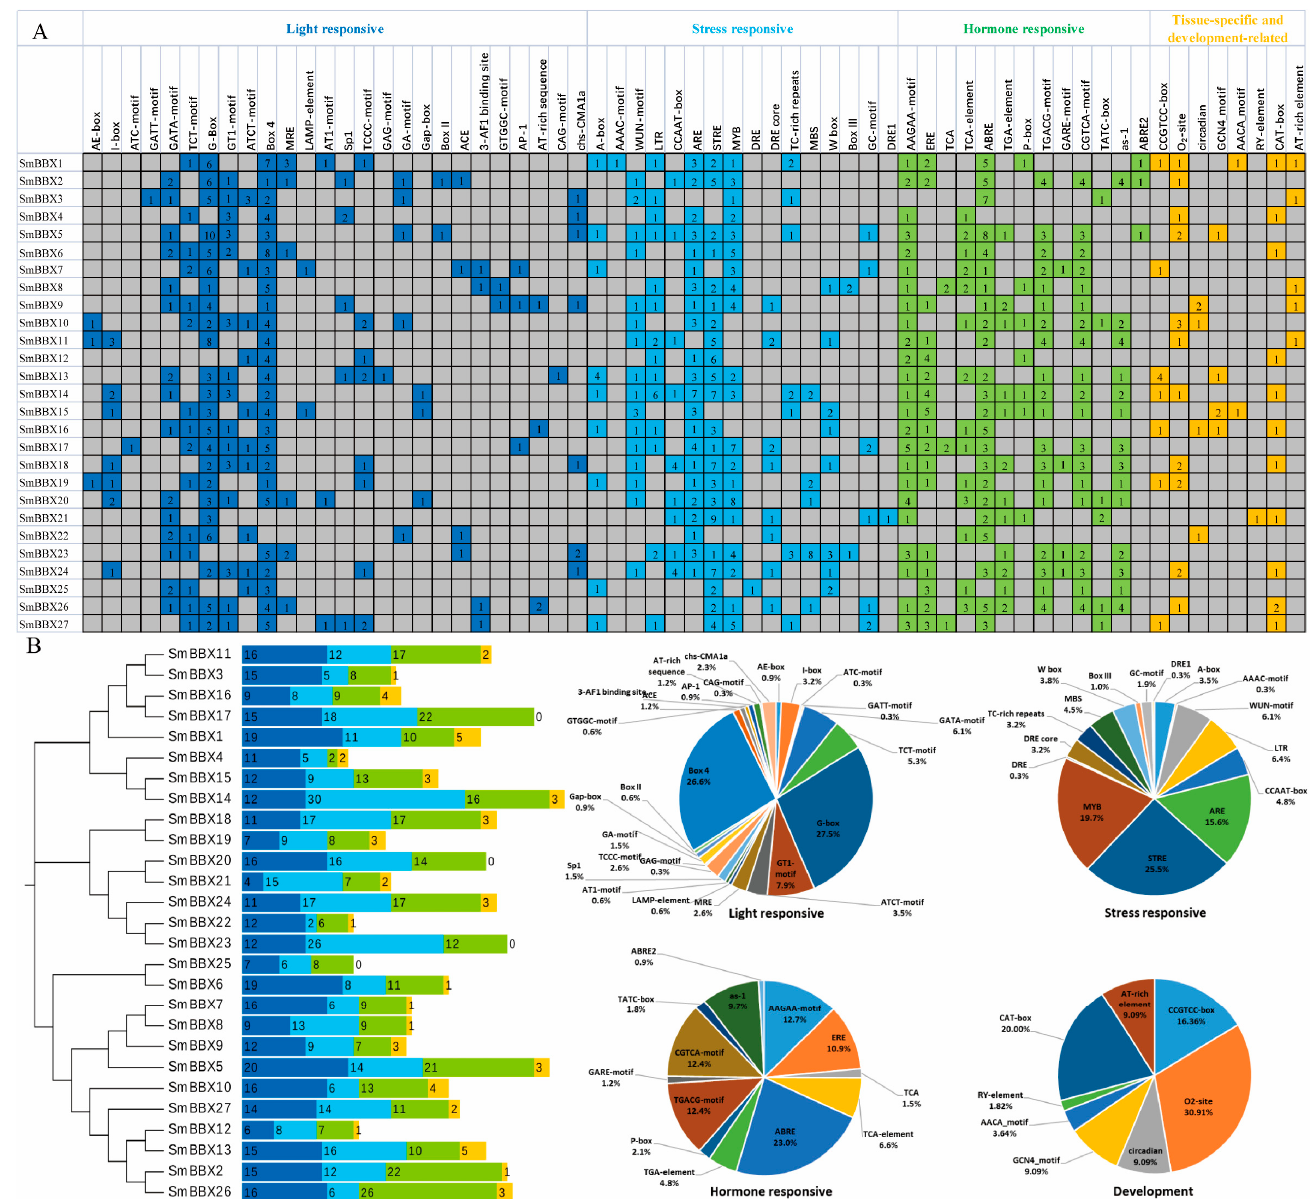
Figure 3. Inspection of cis -element in SmBBXs genes. ( A ) The numbers of different promoter elements in these SmBBX genes are indicated by different colors and numbers in the grid. ( B ) Different colored histograms represent the sum of cis -elements in each category. Pie charts represent the ratios of each promoter element in each category. Table 3. Ka/Ks ratios between paralogous SmBBXs pairs in Salvia miltiorrhiza . Duplicate